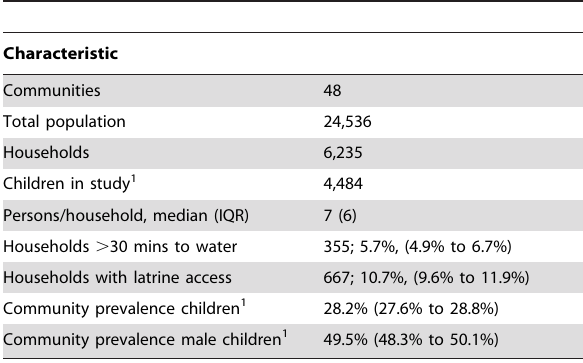
Table 1. Baseline characteristics of cluster-randomized trial in Niger.